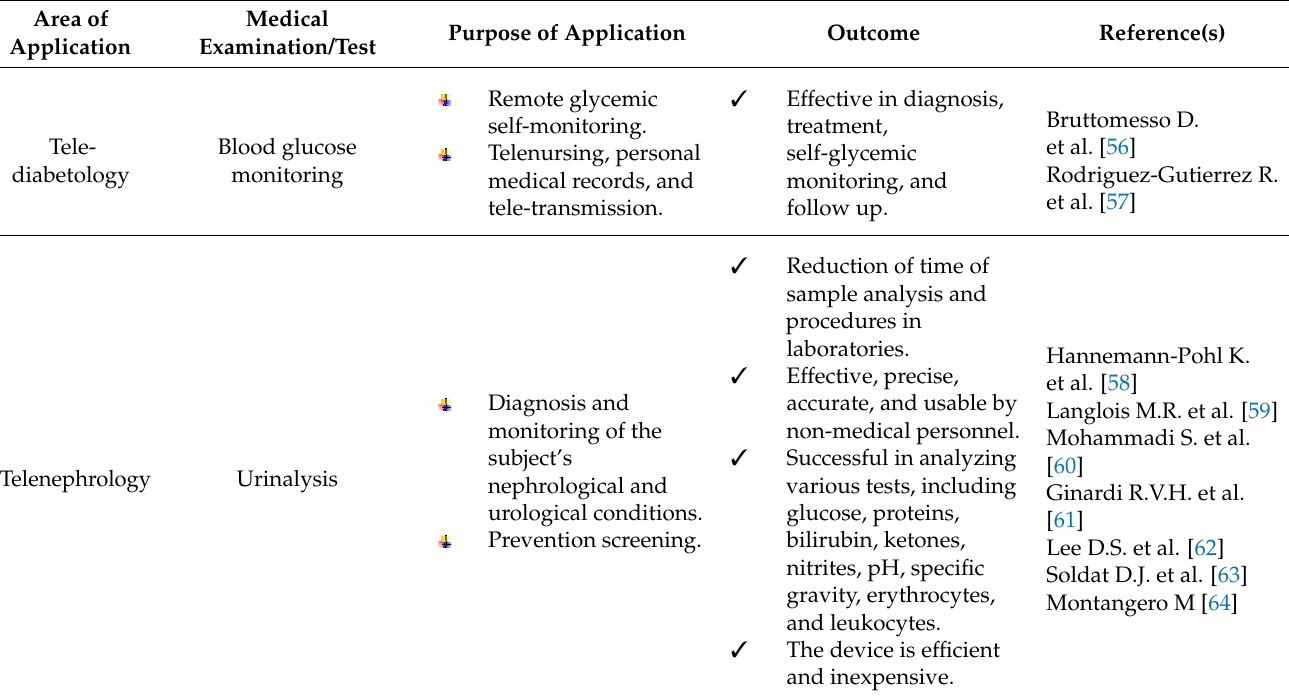
Table 1. Cont. Table 1. Summary of results for the application of telemedicine in different medical examinations/tests.